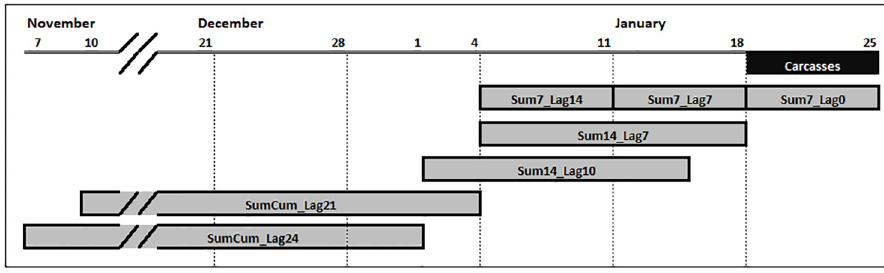
Fig 2. Visual representation of temperature covariates used in generalized linear models for analysis of cold- related manatee mortality. This figure displays the date range and overlap of temperature covariates relative to a 7-day carcass window from 19–25 January. The short-term temperature effects are named Sum#_Lag#, and the cumulative temperature effects are named SumCum_Lag# (where # indicates the number of days the data were summed or